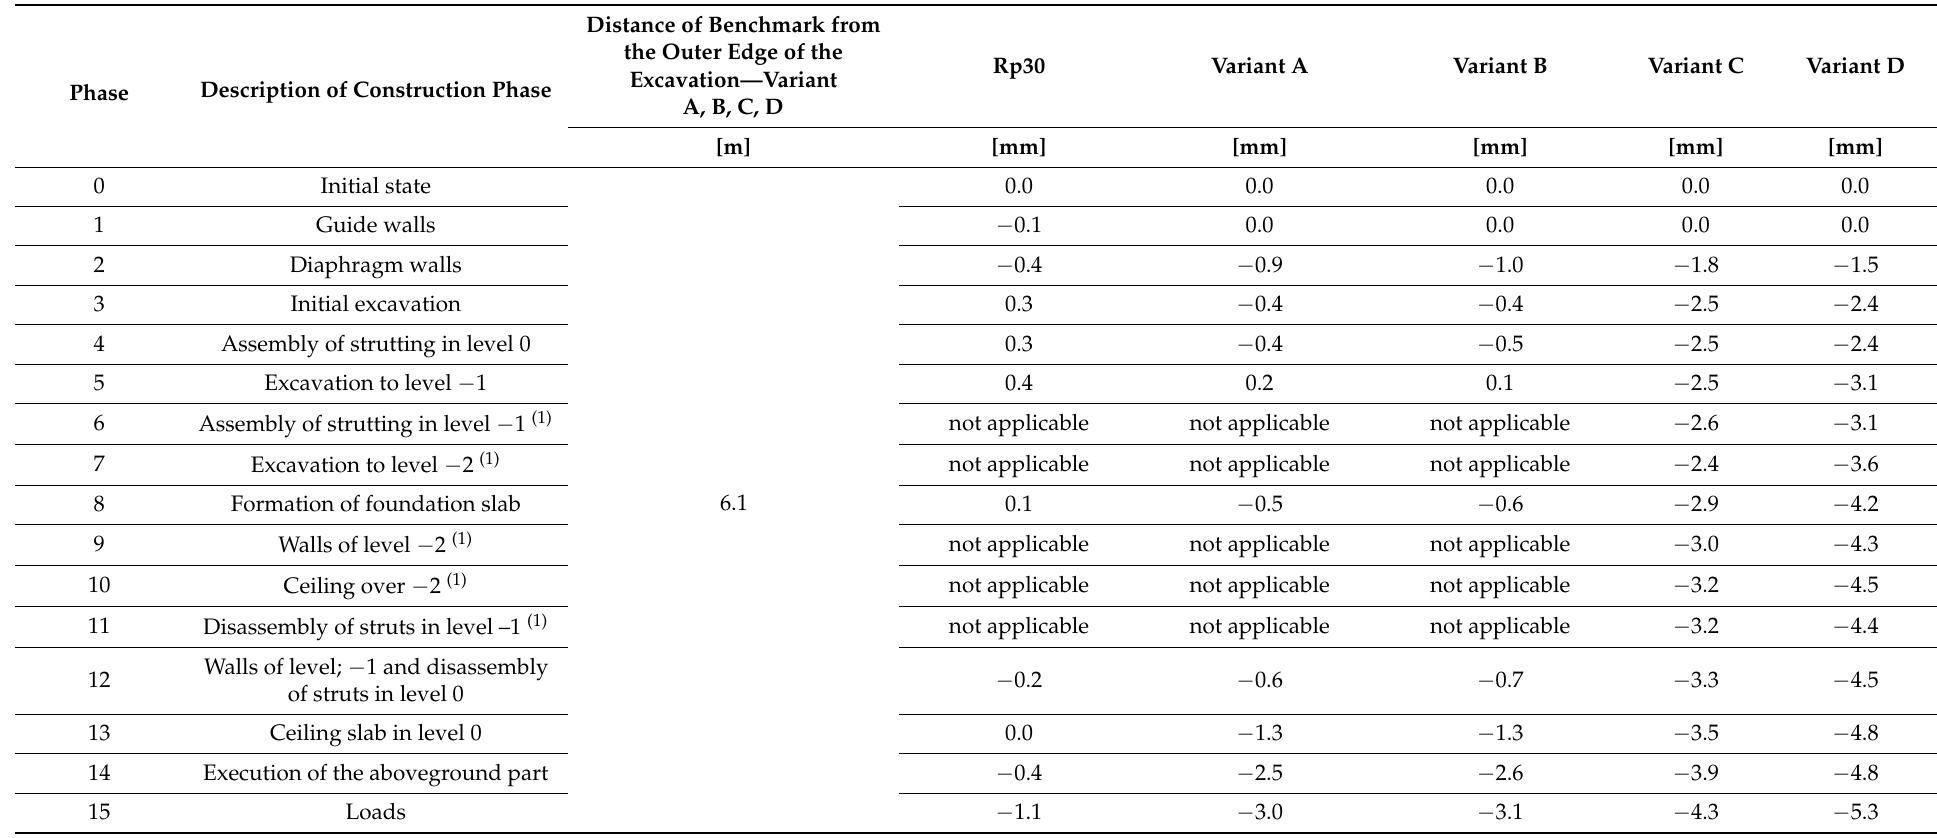
Table 1. Comparison of the results of geodetic measurements of vertical displacements of benchmark Rp30 situated on the western wall of the high-rise building at 1B Ludna Street in individual phases of investment implementation with the values of vertical displacements obtained from numerical